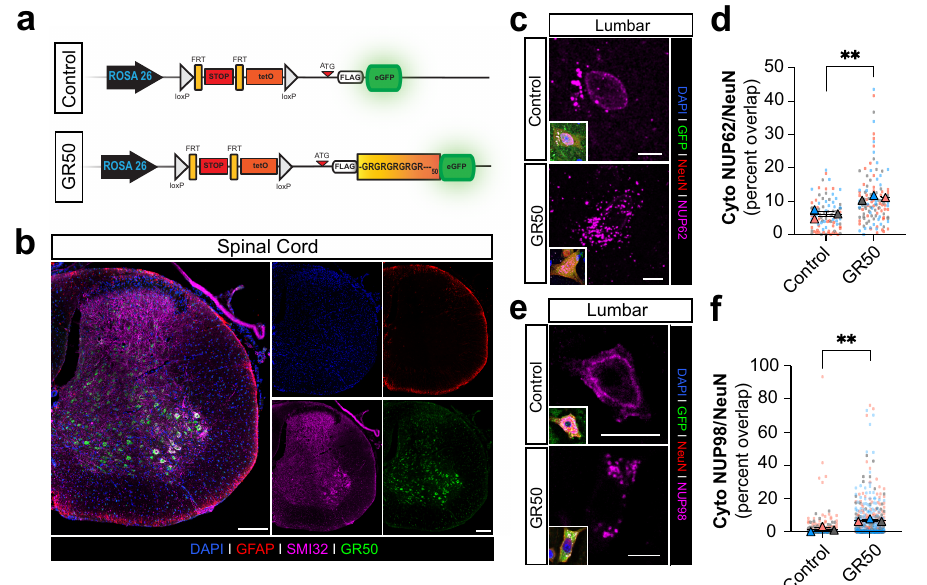
Fig. 4 Poly-GR expression coincides with loss of perinuclear and increased cytosolic NUP62 in vivo. a Top: Schematic of Flexible Accelerated Stop Tetracycline Operator (F.A.S.T.) Cassette driven by the ROSA26 promoter at the ROSA26 locus used to express ATG-driven FLAG-GR50-GFP (GR50) in C57BL/6 mice. GR50 expression occurs upon crossing with a CAG-Cre mouse to excise the fl oxed STOP codon upstream of GR50. Bottom: The same cassette lacking the randomized GR50 sequence but still expressing eGFP is used as a control. b Representative images of GR50 (green) expression in the lumbar spinal cord of a GR50 mouse. GFAP (red) and SMI32 (magenta) denote astrocytes from neurons, respectively. Similar observations were made in a minimum of three biologically independent samples. Scale bar = 200 µ m c Representative images of NUP62 (magenta) in GR50 (green) positive vs control in a 12-month-old mouse. Scale bar = 10 µ m. d Quanti fi cation of NUP62 cytosolic puncta within NeuN-positive neurons of the lumbar spinal cord in 12- month-old mice. Value shown as percent of NUP62 fl uorescence overlap within the whole cell ROI denoted by NeuN fl uorescence. NeuN-positive cells (m) from n = 3 mice. Mean ± s.e.m. Unpaired t-test. ** p = 0.0055. m = 90 control; 124 GR50. e Same as in (C) but for NUP98. f Same as in (D) but for NUP98. NeuN-positive cells (m) from n = 3 mice. Mean ± s.e.m. Unpaired t-test. ** p = 0.0074. m = 276 control; 448